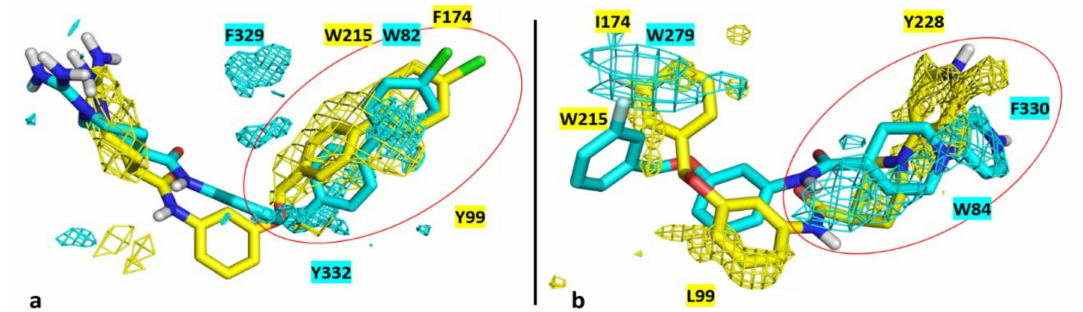
Figure 5. Panel ( a ) shows the structural overlays of 23 within BChE and fXa binding pockets; panel ( b ) shows the structural overlays of 1 within AChE and thrombin binding pockets. Cyan/yellow mesh indicates AChE/BChE and fXa/thr lipophilic MIFs detected by CRY probe. The most relevant residues are highlighted in cyan for AChE and BChE and in yellow for fXa and